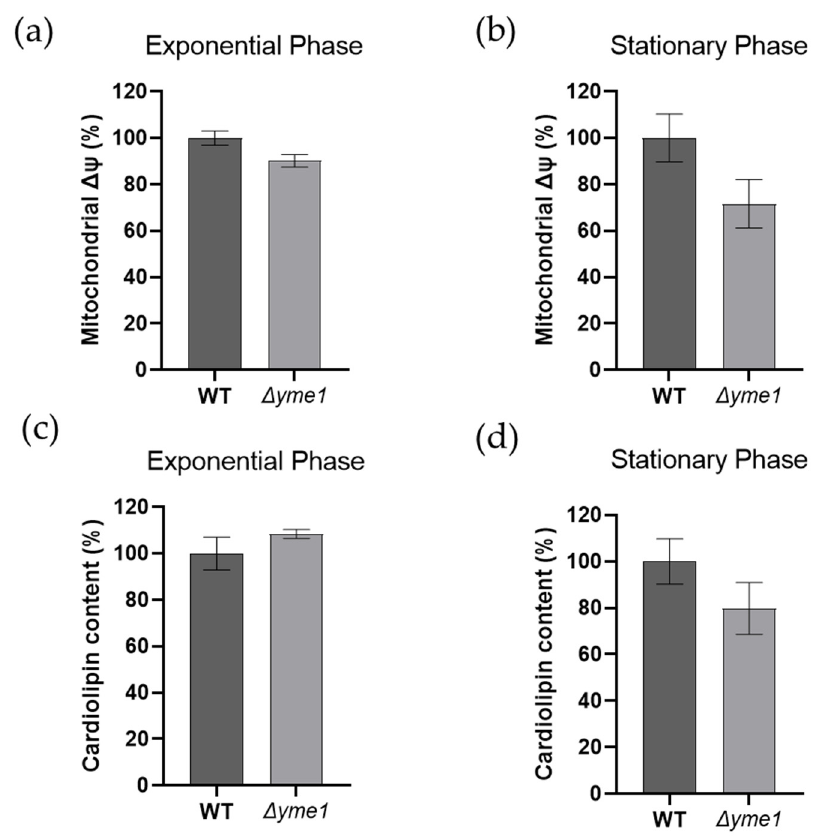
Figure 4. Effects of YME1 deletion on yeast mitochondrial membrane potential ( ∆ ψ ) and cardiolipin content. ( a , b ) Mitochondrial membrane potential ( ∆ ψ ) of yeast cells grown in YPGal at exponential ( a ) and stationary ( b ) phases were measured using fluorescence dye DiOC 6 . ( c , d ) Cardiolipin content of the yeast cells grown in YPGal at exponential ( c ) and stationary ( d ) phases were analysed using flow cytometry coupled with fluorescent dye NAO. For both assays, cells equivalent to OD 600 = 1 were harvested and incubated with the specific dye at 30 ◦ C for 30 min prior to analysis by flow cytometry. The error bars represent standard error of mean (SEM) of three independent experiments of three different cell cultures (n = 9). The statistic was done using Student’s t test, all results show no significant difference with p > 0.05.